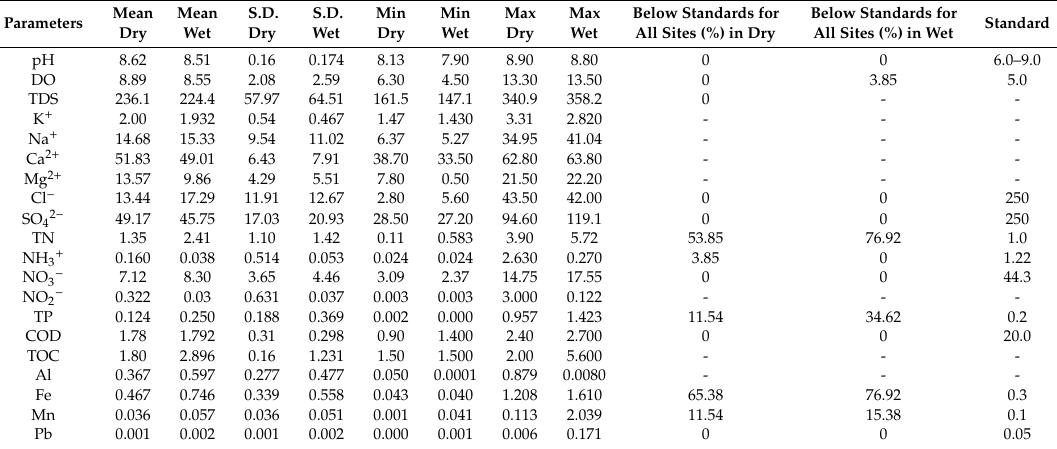
Table A1. Descriptive statistics of water quality parameters in the Beichuan River (all units are in mg / L except